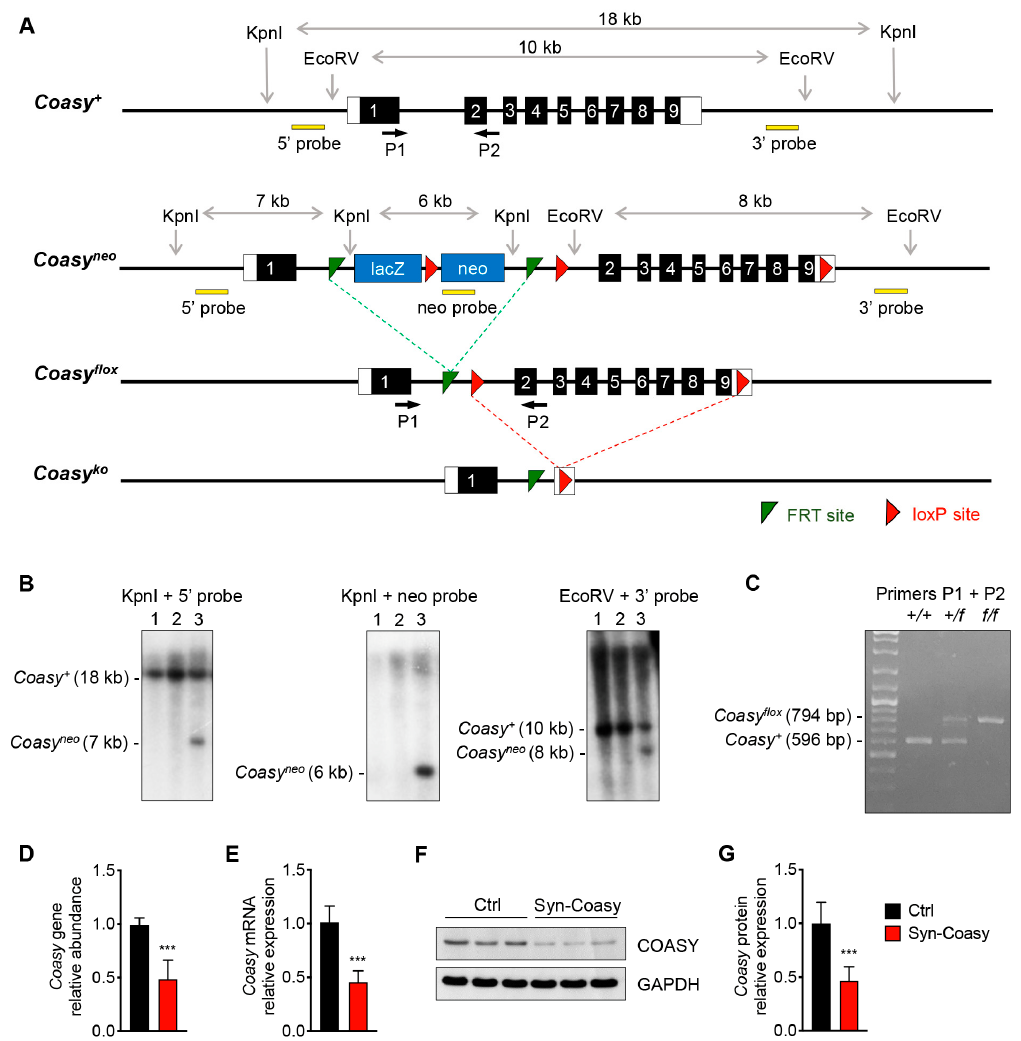
Figure 1. Generation of Cre-loxP Coasy transgenic mice. ( A ) A schematic diagram of the Coasy wild- type locus ( Coasy + ) Homologous recombination of the targeting construct resulted in production of the Coasy neo allele. By sequential mating with FLPE and Cre transgenic mice, Coasy flox and Coasy ko alleles were obtained. The primers (black arrows) used for PCR genotyping, as well as the probes (yellow boxes) used for southern blot analysis are shown. ( B ) Southern blot analysis on KpnI/EcoRV-digested genomic DNA of ES cell clones with 5 ′ , neo and 3 ′ probes, showing wild-type ( Coasy + ) and recombinant ( Coasy neo ) bands. Lane 1 and 2: Coasy +/+ ; lane 3: Coasy +/neo . ( C ) PCR genotyping strategy using primers P1 and P2 to distinguish the wild-type ( Coasy + ) and the floxed ( Coasy flox ) alleles on wild- type (+/+), heterozygous (+/f), and homozygous (f/f) recombinant mice. ( D ) Relative amount of Coasy gene in the brain of Ctrl ( n = 8) and Syn-Coasy ( n = 8), tested by RT-qPCR. ( E ) Relative Coasy mRNA expression in Ctrl ( n = 8) and Syn-Coasy ( n = 8) mice brain. ( F ) Western blot analysis and ( G ) densitometric quantification of Coasy in the brain from Ctrl ( n = 8) and Syn-Coasy ( n = 8) mice. GAPDH was used as the loading control. For ( D ), ( E ) and ( G ), mean ± SD is shown. *** p < 0.001 (Student’s t -test).